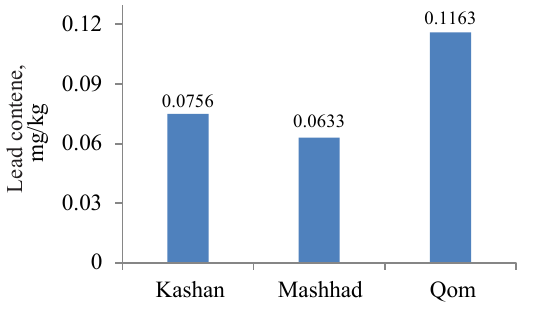
Figure 2 Comparison of lead concentration in eggs from studied regions